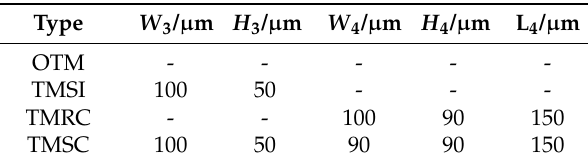
Table 1. Dimensions of different configurations of